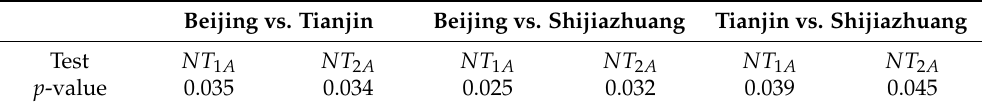
Table 10. p -value of two